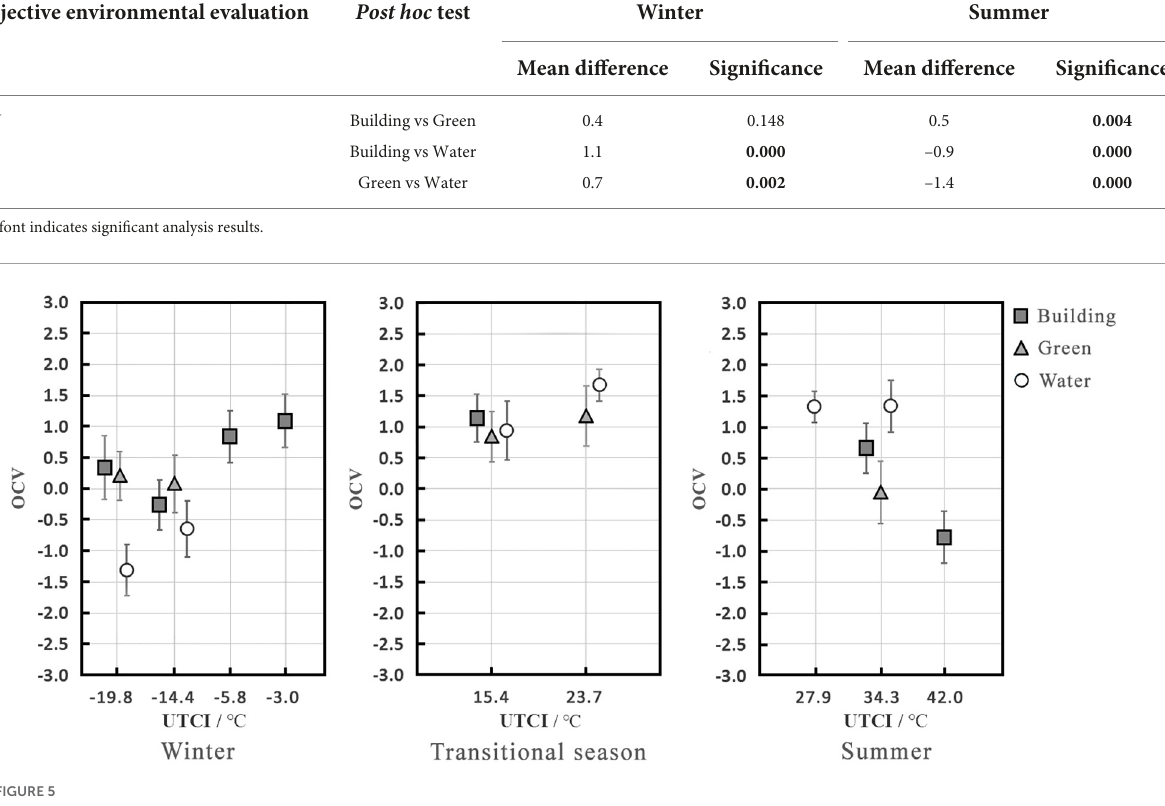
between the building and green landscapes, which were both more comfortable than the water landscape. The water landscape was the most comfortable in summer. There were clear differences between the building and green landscapes, and the comfort of the building landscape was higher than that of the green